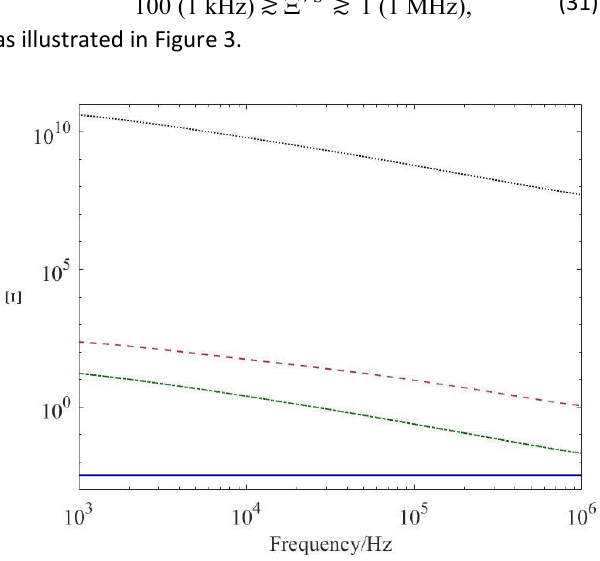
Fig.3: Dimensionless number, Ξ , for SC ( – ), VS ( – – ), AT ( - ⋅- ) and EL ( ⋅⋅⋅